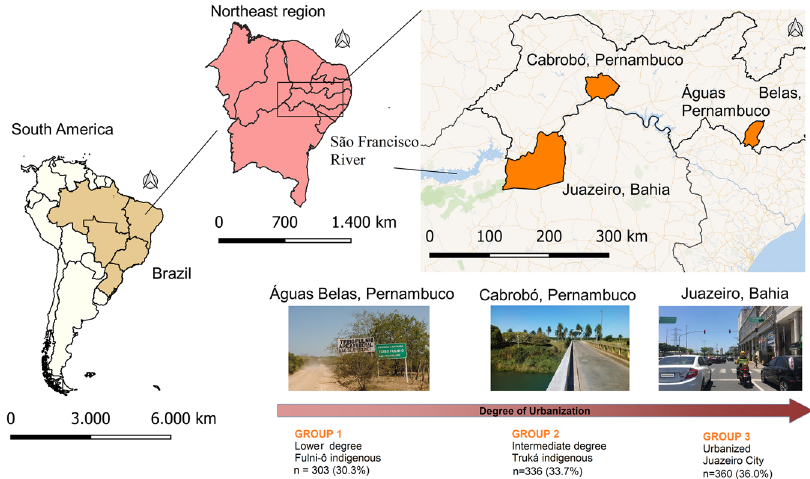
Fig. 1 Study population and territorial area, for Fulni-ô Indigenous people, Truká Indigenous people, and urban non-Indigenous population in Juazeiro. Made with Natural Earth. Map base layers were modi fi ed in QGIS software version 2.18. Pictures from the PAI researchers (no Indigenous